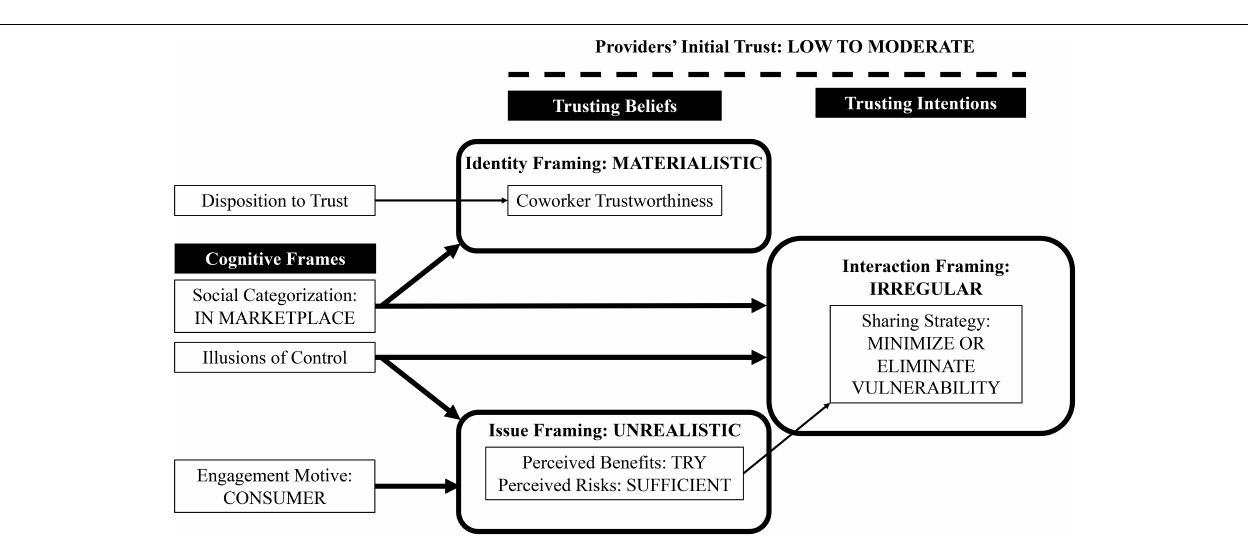
FIGURE 3 | Providers’ initial trust when coworker collaborative consumption is framed as sharing within a community of citizens.